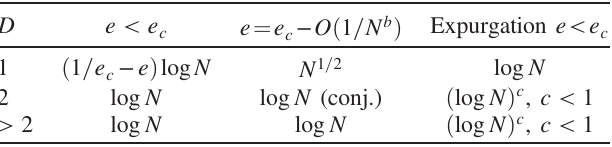
TABLE I. Random Clifford circuit encoding depths required to reach zero failure probability for finite-rate codes under erasure − O ð 1 =N b Þ denotes coding errors in D dimensions. Here, e c arbitrarily close to the critical region of the optimal erasure threshold in the thermodynamic limit. We find b ¼ 1 for the fixed-fraction erasure model and b ¼ 1 = 2 for the IID model. Here, D ¼ 2 is the marginal dimension for the relevance of spatial randomness in the errors to the threshold behavior, which makes the scaling at the optimal threshold difficult to reliably determine from numerics or Imry-Ma arguments. The last column shows the results upon expurgation of bad logical operators using quantum measurements (see Sec.